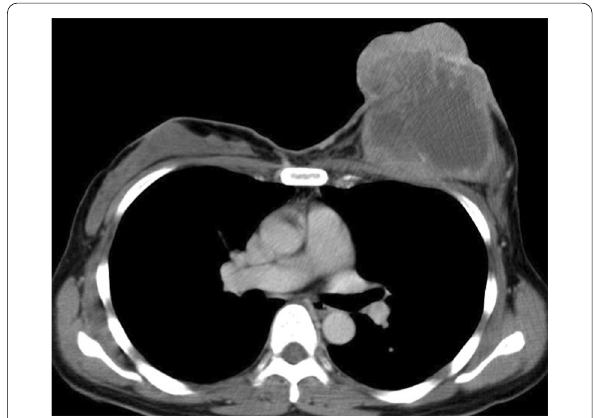
Fig. 2 Left breast cancer. Contrast-enhanced computed tomography showing the tumor projecting to the skin, approximately 9.3 cm in